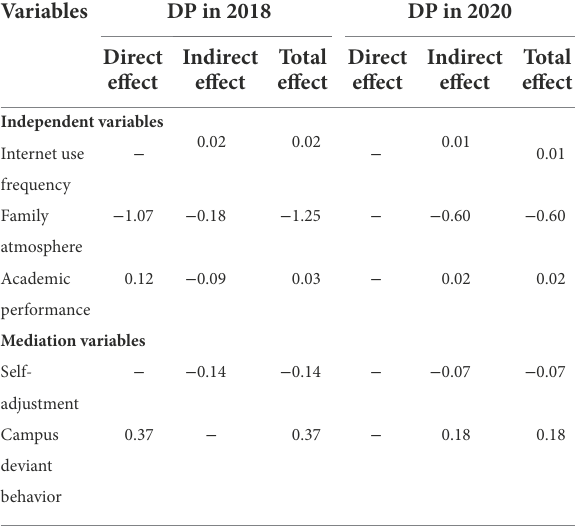
TABLE 3 Direct and indirect effects of depression in